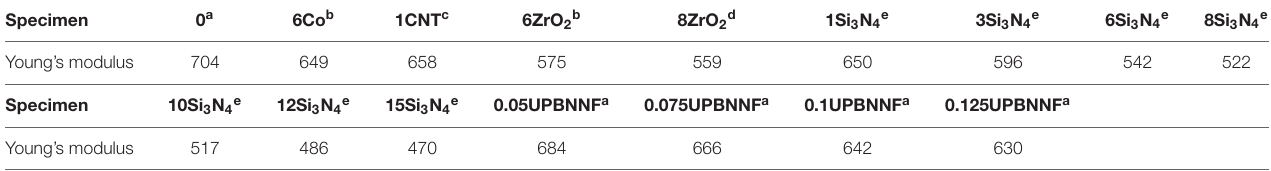
TABLE 2 | Young’s modulus of some WC composites reported in published papers.